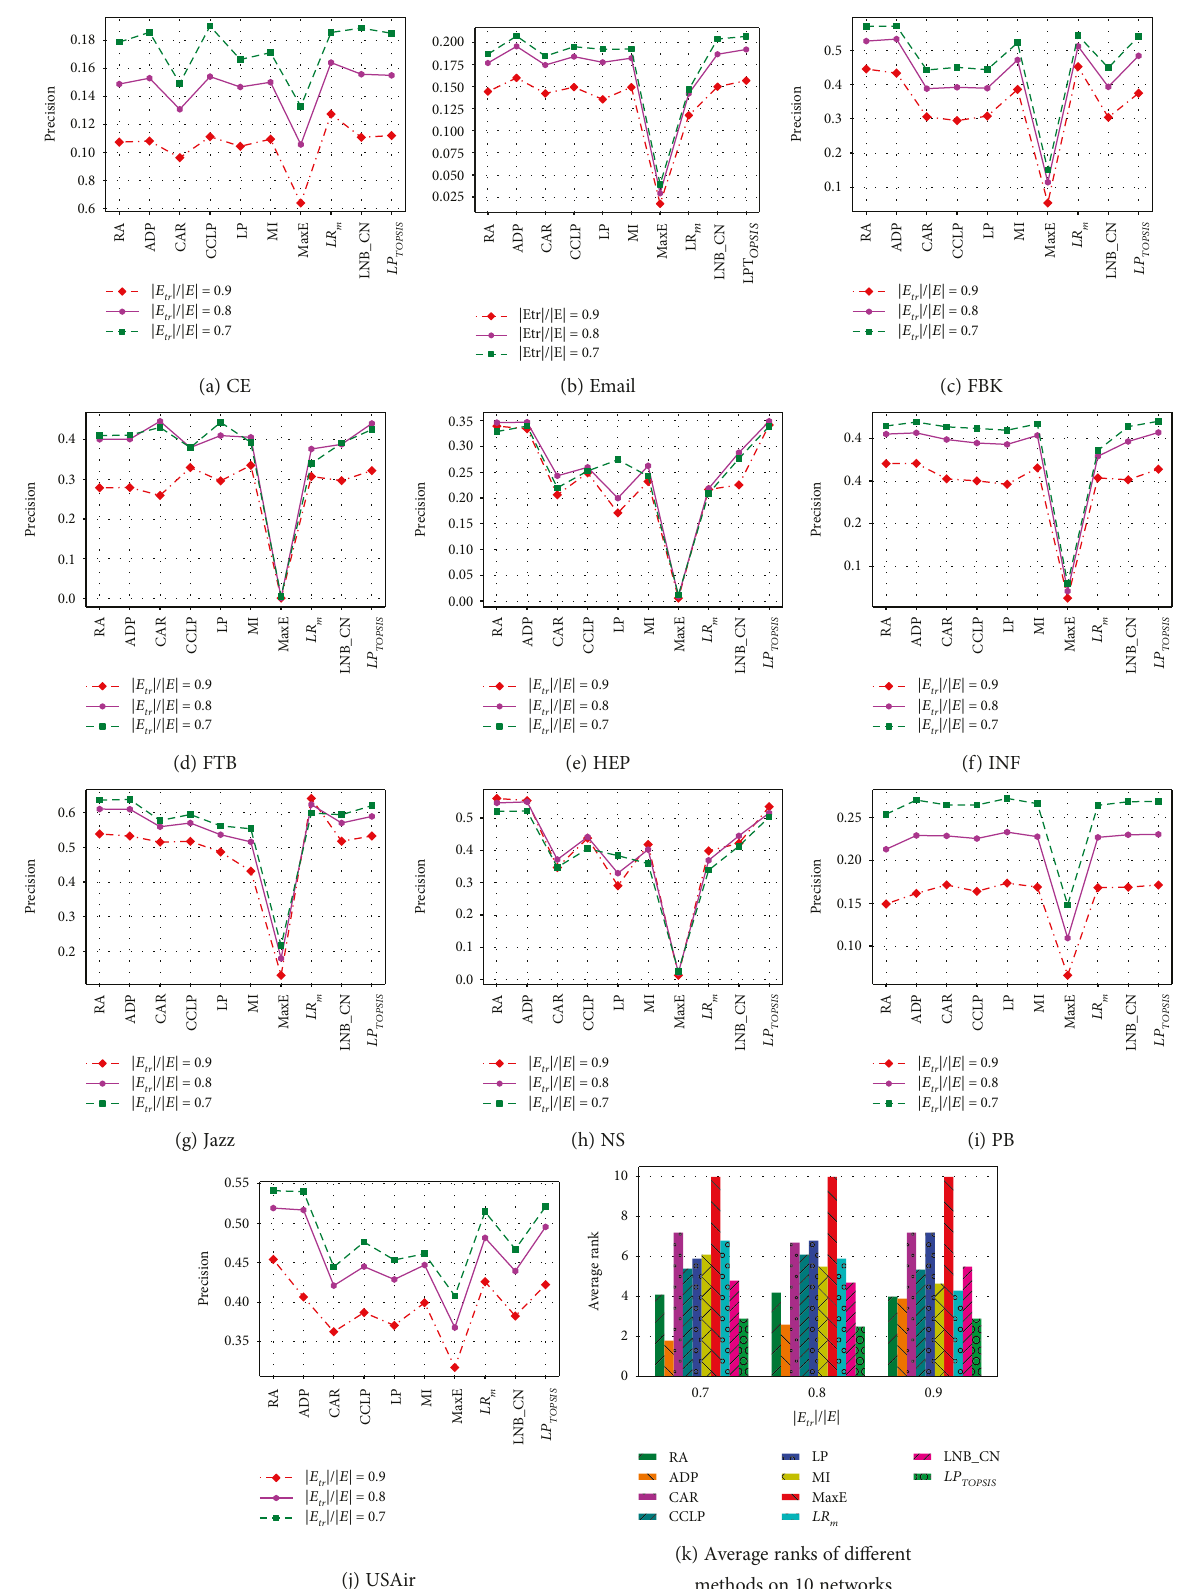
Figure 8: Precision results on 10 networks with di ff erent proportions of training set. The results are the average of 50 independent ∣ for all implementations. In this fi gure, L = ∣ E ts